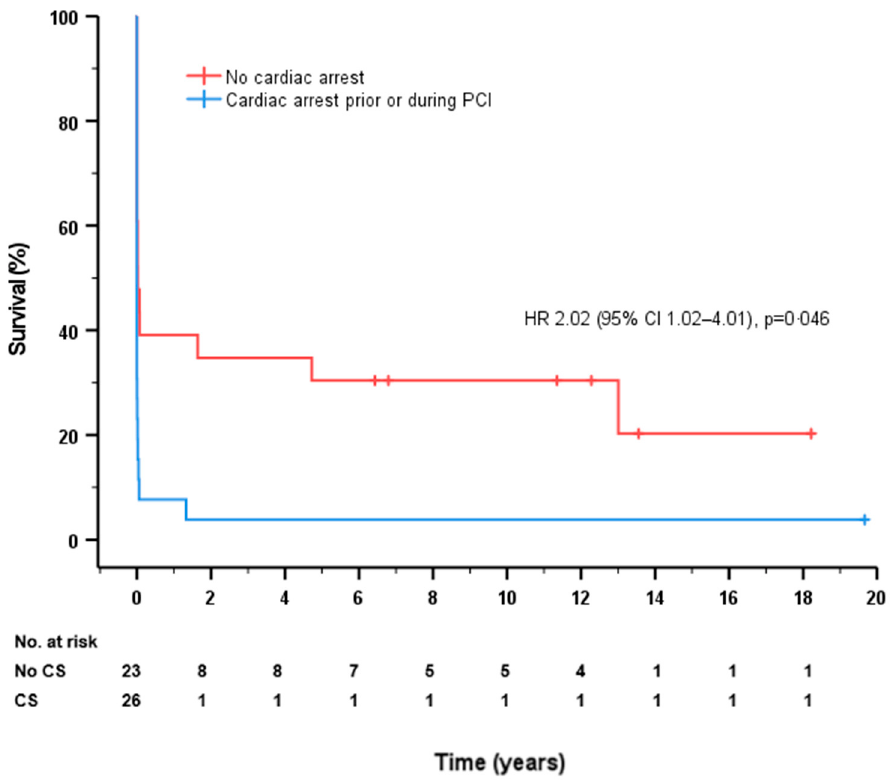
Figure 3. Survival curves for patients without cardiac (red line) or cardiac arrest prior or during PCI (blue line).